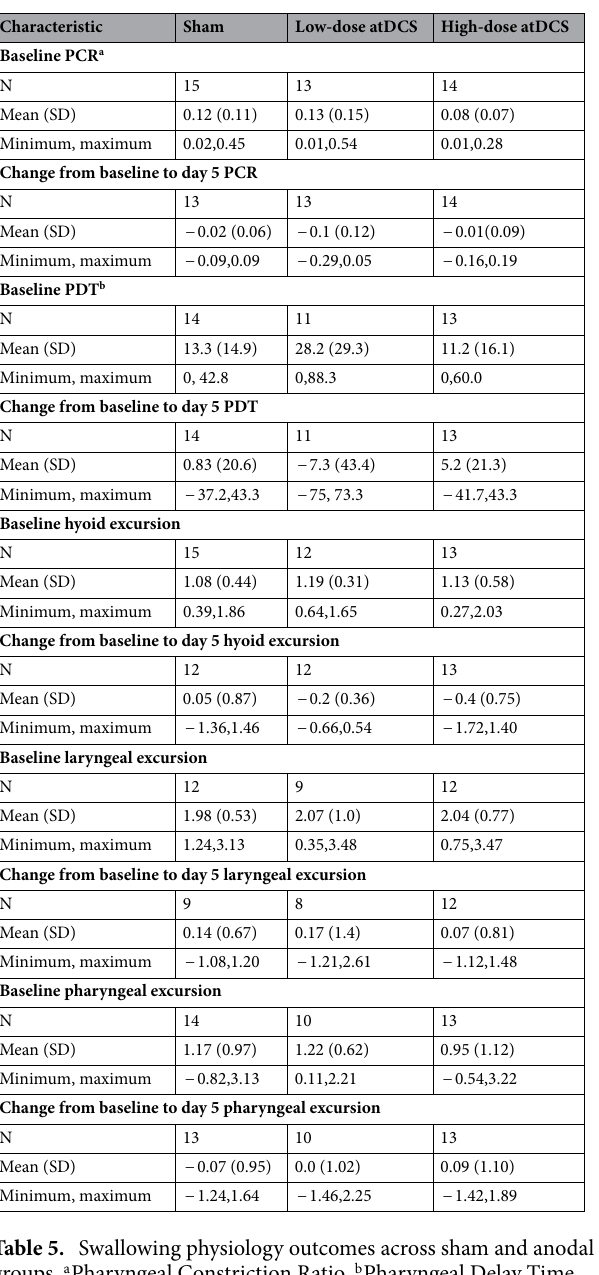
Characteristics